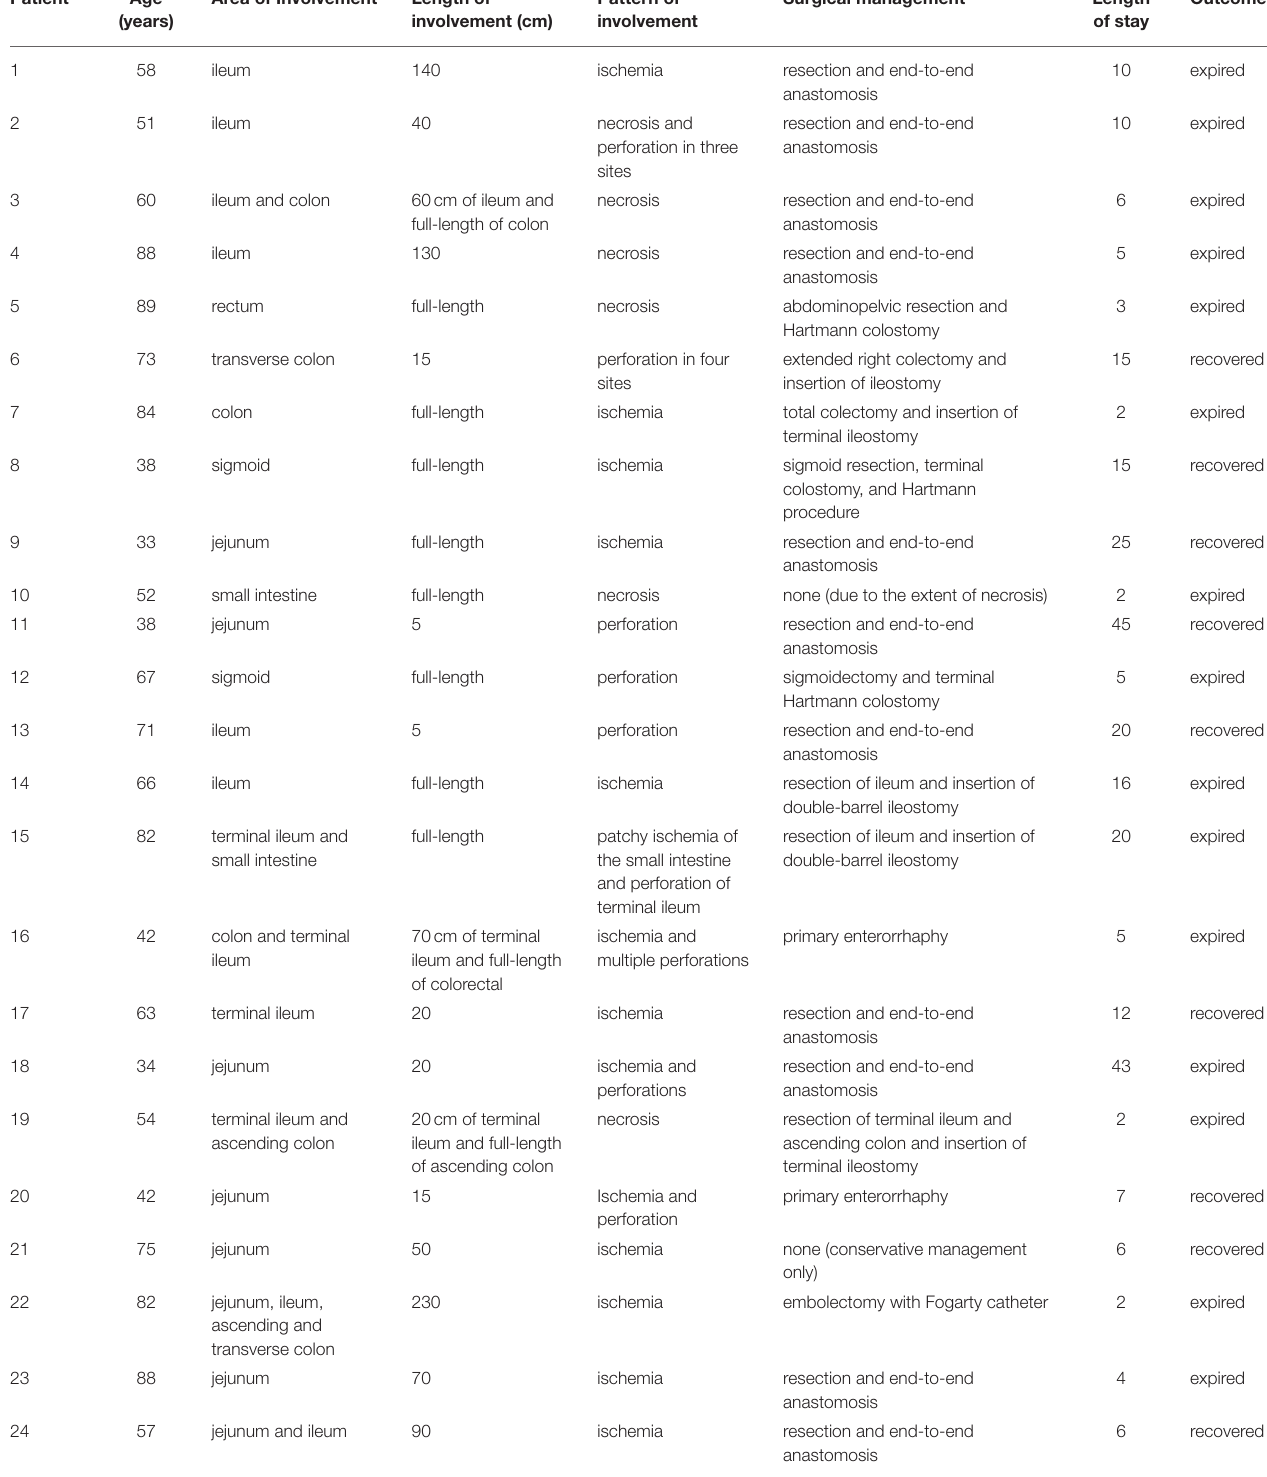
TABLE 3 | Progression and outcome of intestinal ischemia in the patients.